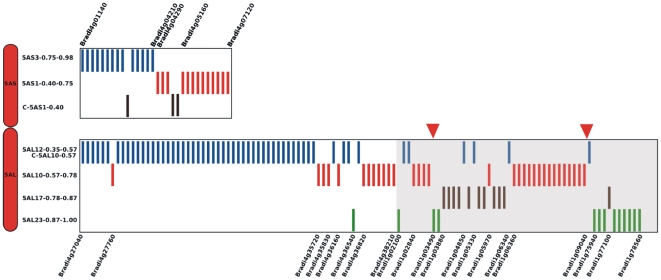
Consistency between virtual gene order and marker distribution.The figure integrates the genome zipper and the deletion bin map (from Figure 6) in order to verify their collinearity. Each gene shared by the two maps is represented by a bar and it is positioned according to the bin (seven levels on the vertical axis, indicated on the left) and to the zipper (horizontal axis). If the two maps are fully consistent then the zipper genes would fill one bin at a time from the top to the bottom of the figure. Although, as expected, the correspondence of the two maps is not perfect, genes within a bin tend to be contiguous within the zipper. The darker area on the 5AL arm represents the portion of the zipper syntenic with Brachypodium chromosome 1, while the rest corresponds to Brachypodium chromosome 4. The apparent lack of collinearity at the end of the long arm may be explained by an inversion (bracketed by red arrowheads) occurred between wheat and Brachypodium. Some relevant zipper genes are indicated at the top and bottom of the figure.